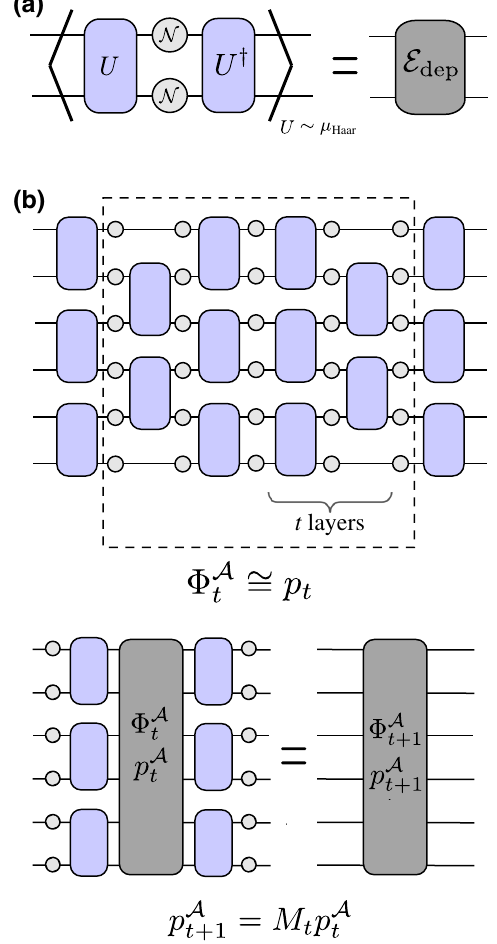
FIG. 2. (a) Averaging over Haar-random unitary U yields a two-qubit depolarizing channel E dep . (b) Schematic depiction of averaging over the circuit ensemble shown in Fig. 1—we average from the center of the circuit outwards, and derive an effective Markov chain that describes the channels